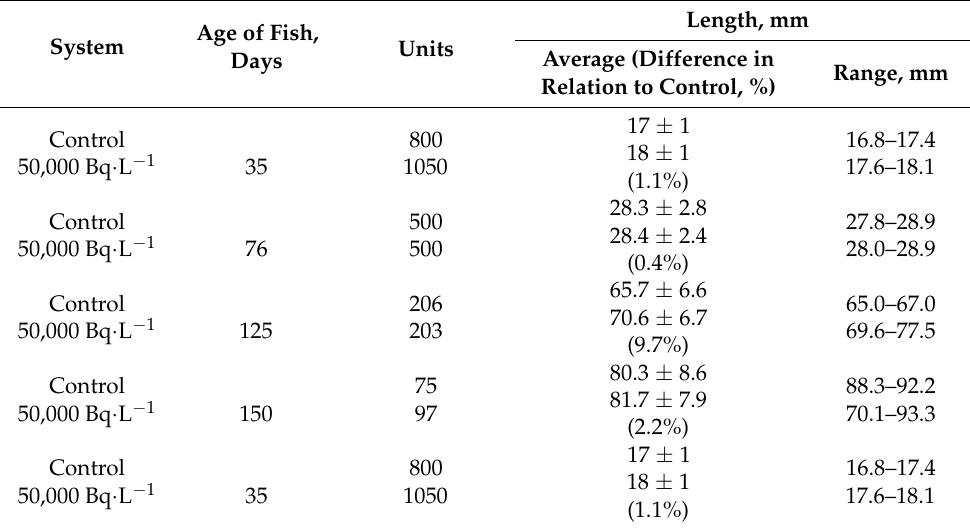
Table 4. Changes in the length of the fish fry in relation to the control system ( p = 0.95). Length, mm Age of Fish, System Units Average (Difference in Days Range, mm Relation to Control, %) Control